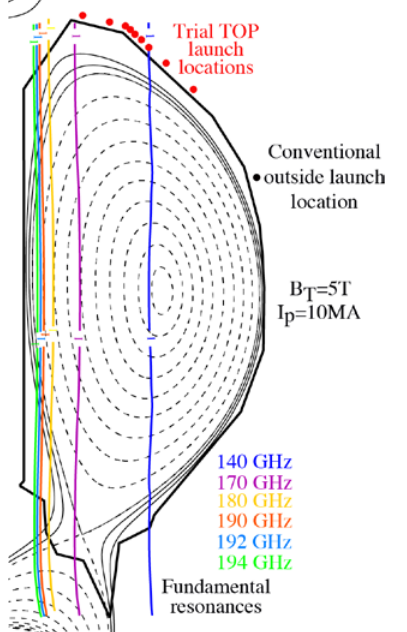
Figure 5:Various launch locations and frequencies studied for high off-axis ECCD efficiency on CFETR.